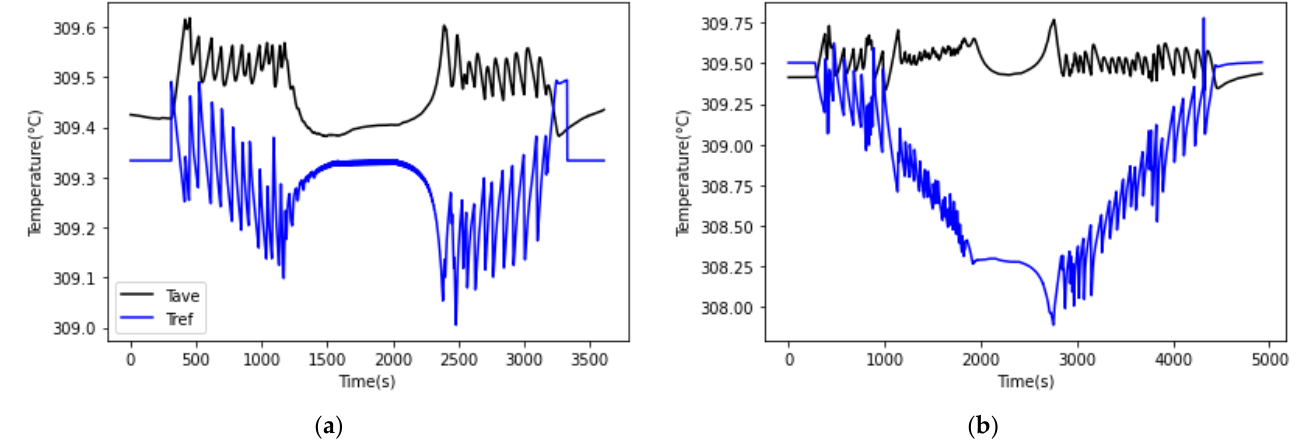
Figure 9. Comparison of Tref and Tavg during the transitions between pure electric power generation and mixed-mode power generation. Results are shown for 15% TPE ( a ) and 50% TPE ( b ).